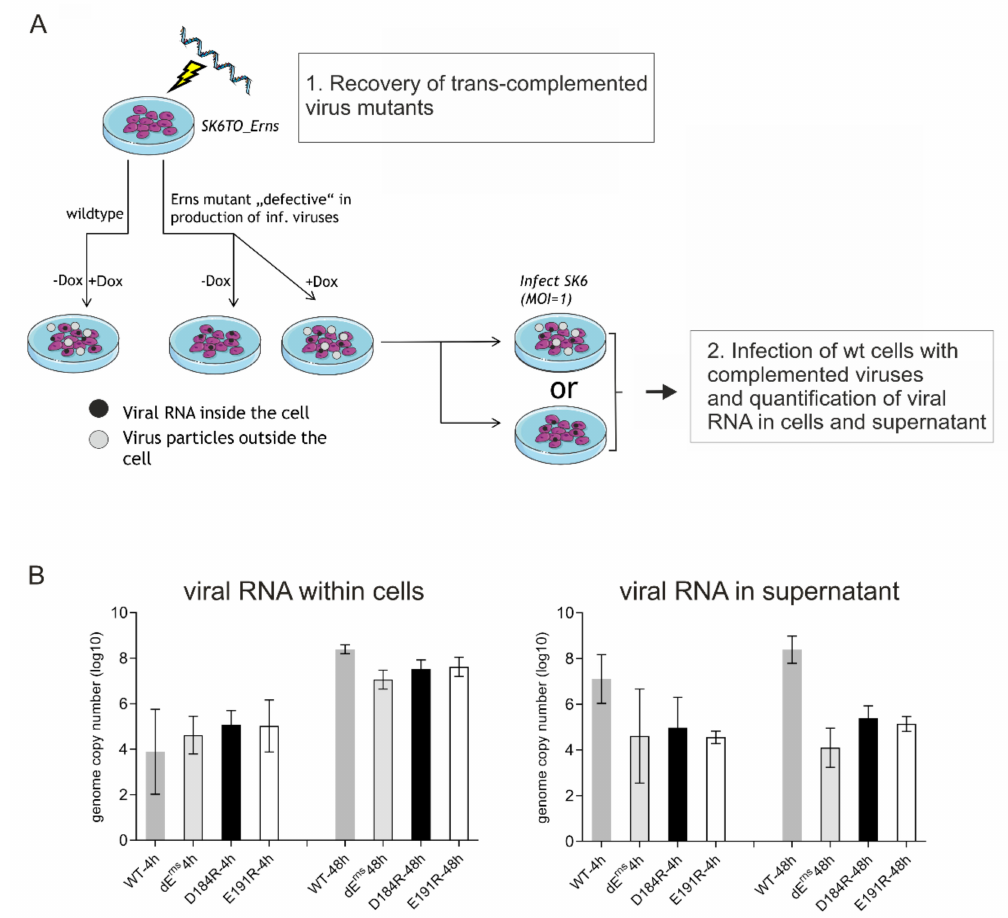
Figure 14. Determination of viral RNA levels in cells and cell culture supernatant. ( A ) Schematic presentation of the method used for propagation of mutant viruses. Step 1: SK6_TO cells were transfected via electroporation and E rns production (by the cells) was induced with doxycycline. Viral particles were recovered from wt or defective mutant RNAs due to the trans complementation with wt E rns . Step 2: The recovered infectious viruses were used in single cycle experiments for infection. Viral RNA was harvested from cells and supernatant and then used for quantification of viral RNA displaying the wt sequence or an E rns deletion mutant or mutants with deleterious exchanges. Viral RNA in the supernatant should result from secretion of viral particles shown here as gray dots. ( B ) Results of viral RNA quantification via qRT-PCR in lysates (left) or equivalent amounts of supernatant of SK6 cells infected with wt CSFV or stocks of mutants propagated in complementing SK6TO_E rns cells. Infection was done with an MOI of one. Harvest for total RNA isolation was done separately for cells and supernatant at 4h or 48 h p.i. and the viral genome copy number was determined via real time RT-PCR. The bar diagrams summarize the results of three independent experiments showing the mean log10 values of the viral genome copy numbers with standard deviation